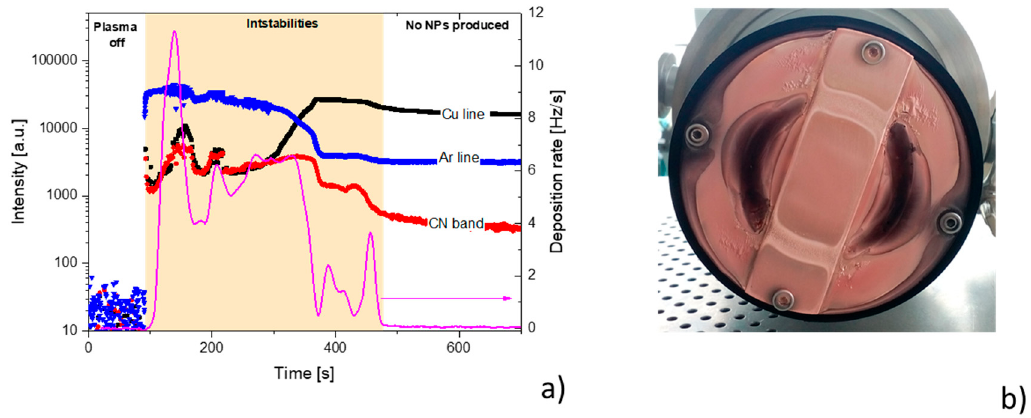
Figure 6. ( a ) Time evolution of intensities of spectral emission lines and bands of Ar, Cu, and CN measured by emission spectrometer (AvaSpec 3648, Avantes) together with the deposition rate of produced NPs. ( b ) Photography of Nylon/Cu composite target after the plasma operation. RF power 80 W.